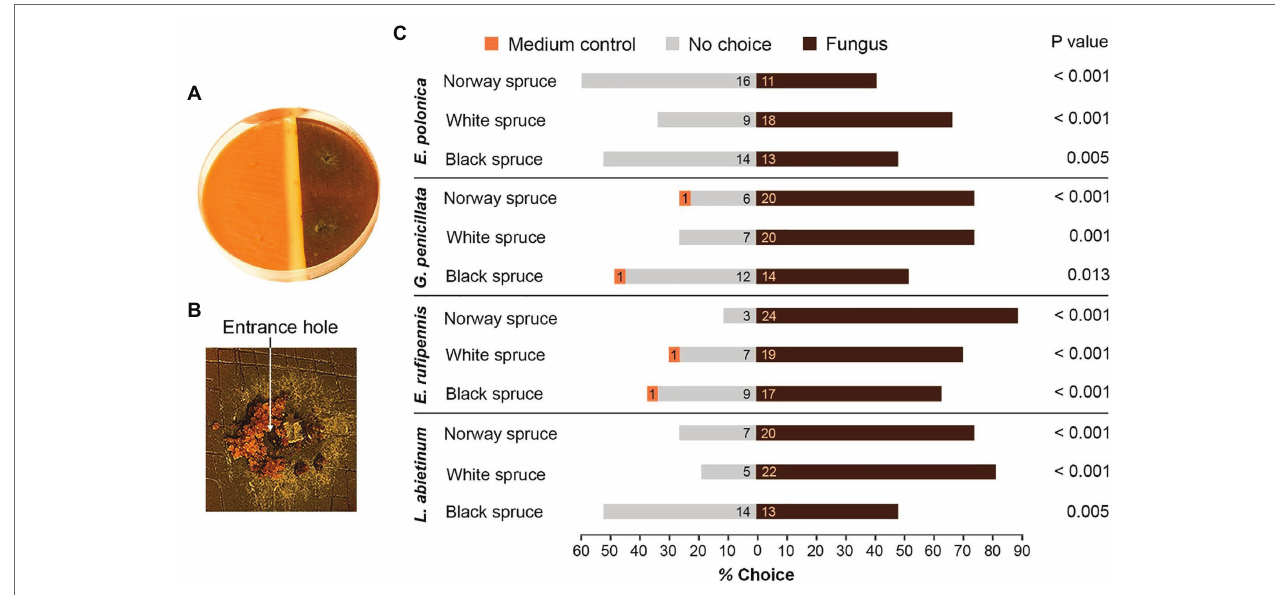
FIGURE 2 | Host preferences of adult I. typographus in the presence of bark beetle-associated fungi. (A) Single-species choice arena containing semi-circles of bark agar medium made from Norway spruce, black spruce, or white spruce. The medium was either colonized by one of four fungal species 15 days earlier (right) or was left un-colonized (medium control, left). (B) Three beetles were released into each arena. Most of beetles entered fungus-colonized medium just beside the fungal inoculation plug (arrow). (C) The percentage of beetles that entered un-colonized medium (Medium control), fungus-colonized medium (Fungus) or remained on the surface (No choice) 48 h after introduction of beetles to the arenas (numbers inside the bars show total number of beetles that made their choice). p values show the outcome of Wilcoxon signed-rank tests comparing fungus and medium control for each combination of spruce species and fungal species ( n = 9 individual trees per spruce species). E, Endoconidiophora ; G, Grosmannia ; and L, Leptographium